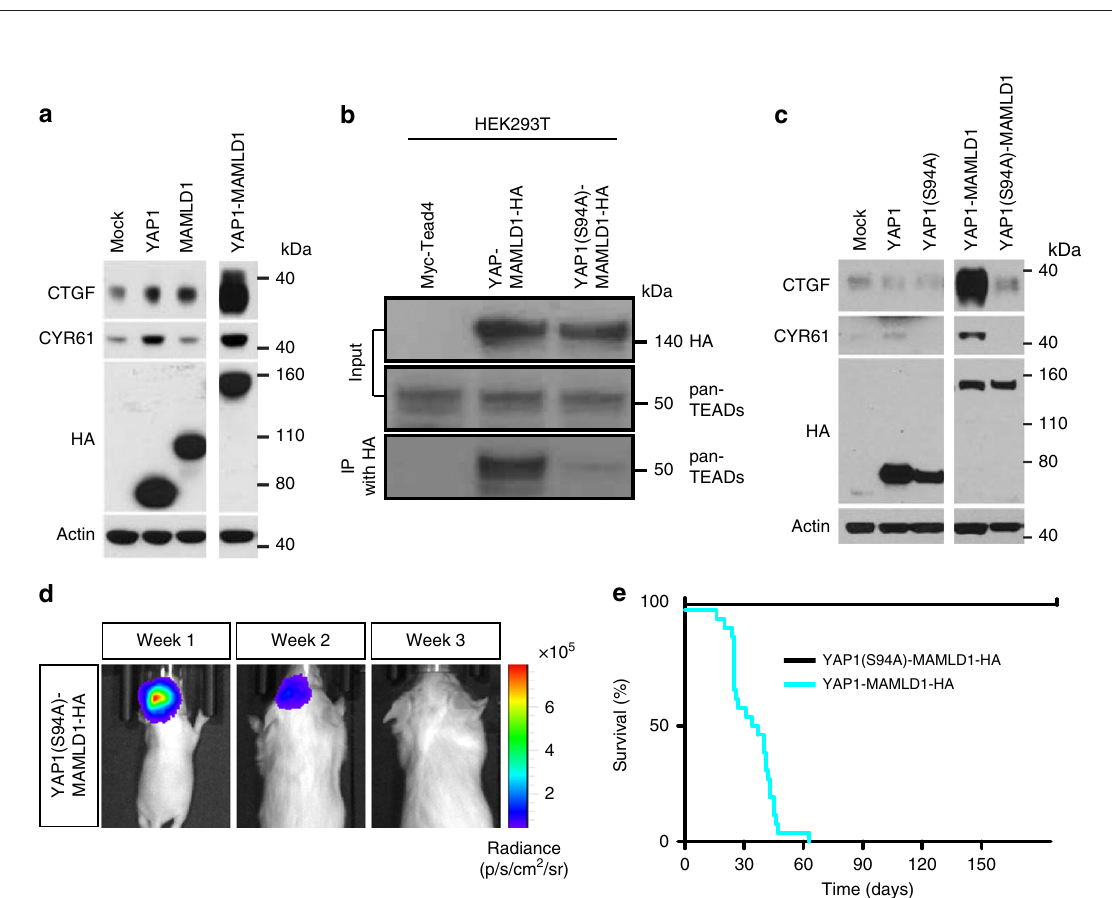
Fig. 5 TEAD and NFI motifs are enriched in YAP1-bound cis -regulatory elements in ST-EPN-YAP1s. a Ranked group-speci fi c enhancers that overlap with group-speci fi c YAP1 peaks. Selected genes with highest correlation in respective topology-associated domains of enhancers are indicated. Right side from dashed line represents super-enhancers. b YAP1 and H3K27ac ChIP-Seq data across human primary ST-EPN-YAP1 and ST-EPN-RELA tumor samples ( n = 3 for each entity) in the NDEL1 locus. YAP1-binding regions and H3K27Ac-marked enhancer regions of ST-EPN-YAP1 and ST-EPN-RELA colored cyan and red, respectively. TEAD and NFI motifs are shown by black bars. c Box plot of NDEL1 gene expression level across molecular groups of human ependymal tumors. The center line, box limits, whiskers, and points indicate the median, upper/lower quartiles, 1.5× interquartile range and outliers respectively. d Gene ontology (GO) analysis of 129 genes that showed highest correlation within topology-associated domains in ST-EPN-YAP1-speci fi c enhancers that overlap with ST-EPN-YAP1-speci fi c YAP1 peaks. Darker color intensity re fl ects a smaller p -value of GO term enrichment, while the bubble size re fl ects the term frequency. e Top fi ve transcriptional factor-binding motifs enriched within YAP1 peaks speci fi c to ST-EPN-YAP1 tumors. The enrichment p -values are computed by HOMER tool using binomial test. f , g Transcription factor motif enrichment in group-speci fi c YAP1 peaks overlapping with group-speci fi c enhancers/super-enhancers in human ST-EPN-YAP1 f or ST-EPN-RELA g tumors. Colored lines indicate location of TEAD1 – 4-binding motifs